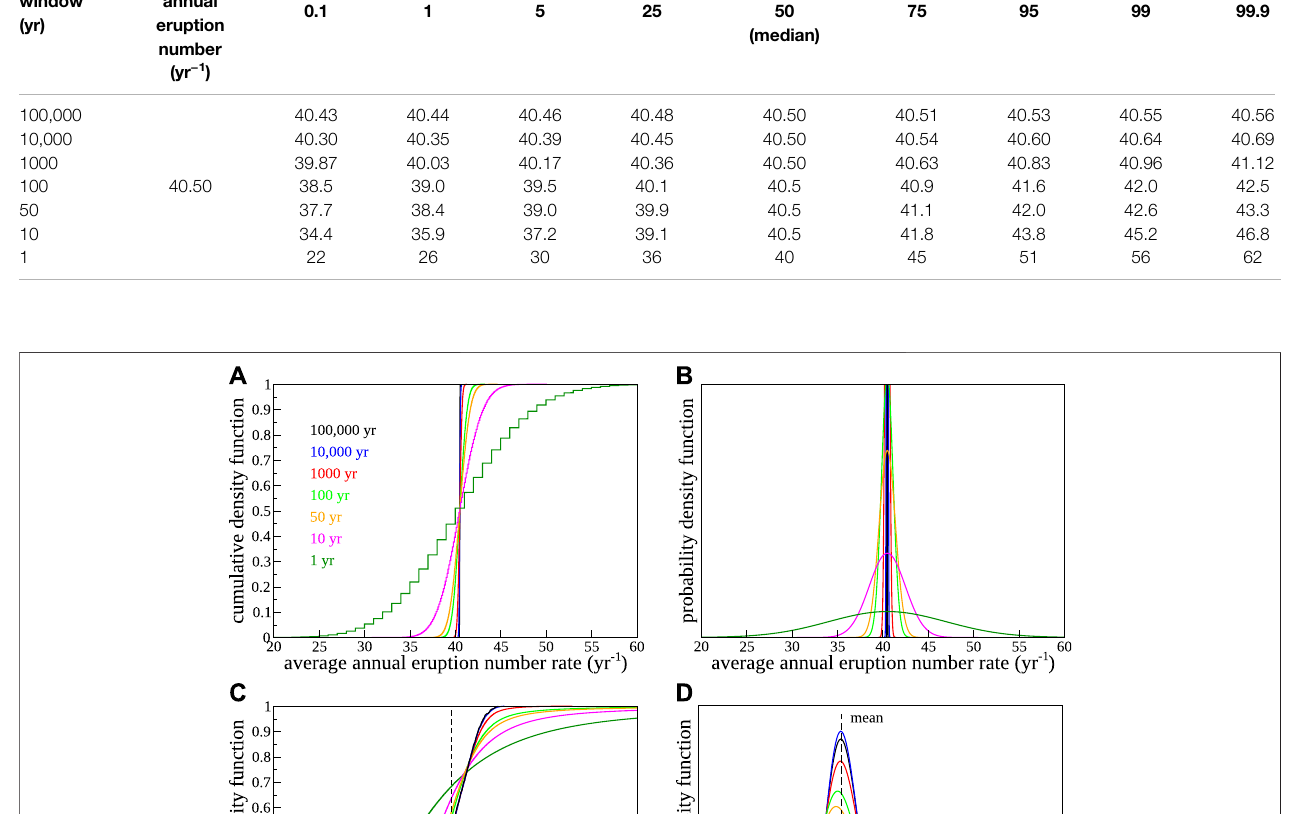
TABLE 1 | Computed average annual number of eruptions from subaerial volcanism over different time windows. Time window